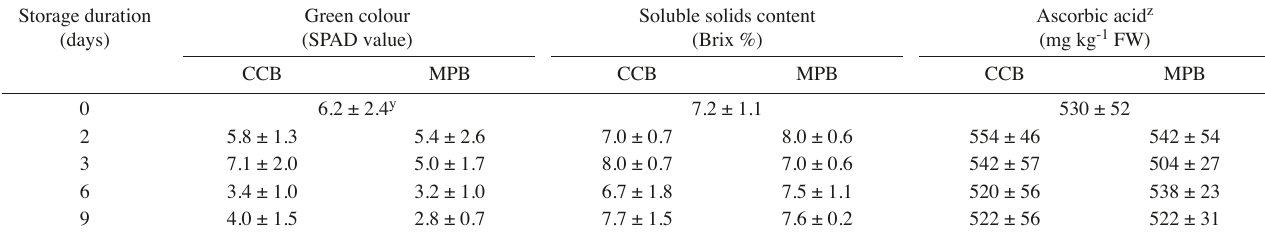
Tab. 1: Effects of two types of corrugated boxes on the colour, soluble solids content, and ascorbic acid content of cabbage during storage. Storage